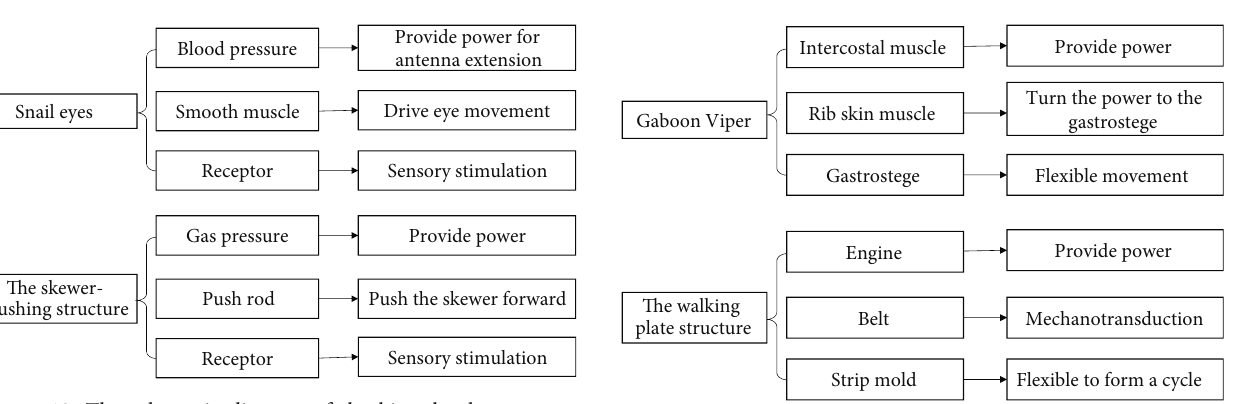
Figure 12: The schematic diagram of the biotechnology system transformation of the walking plate structure.